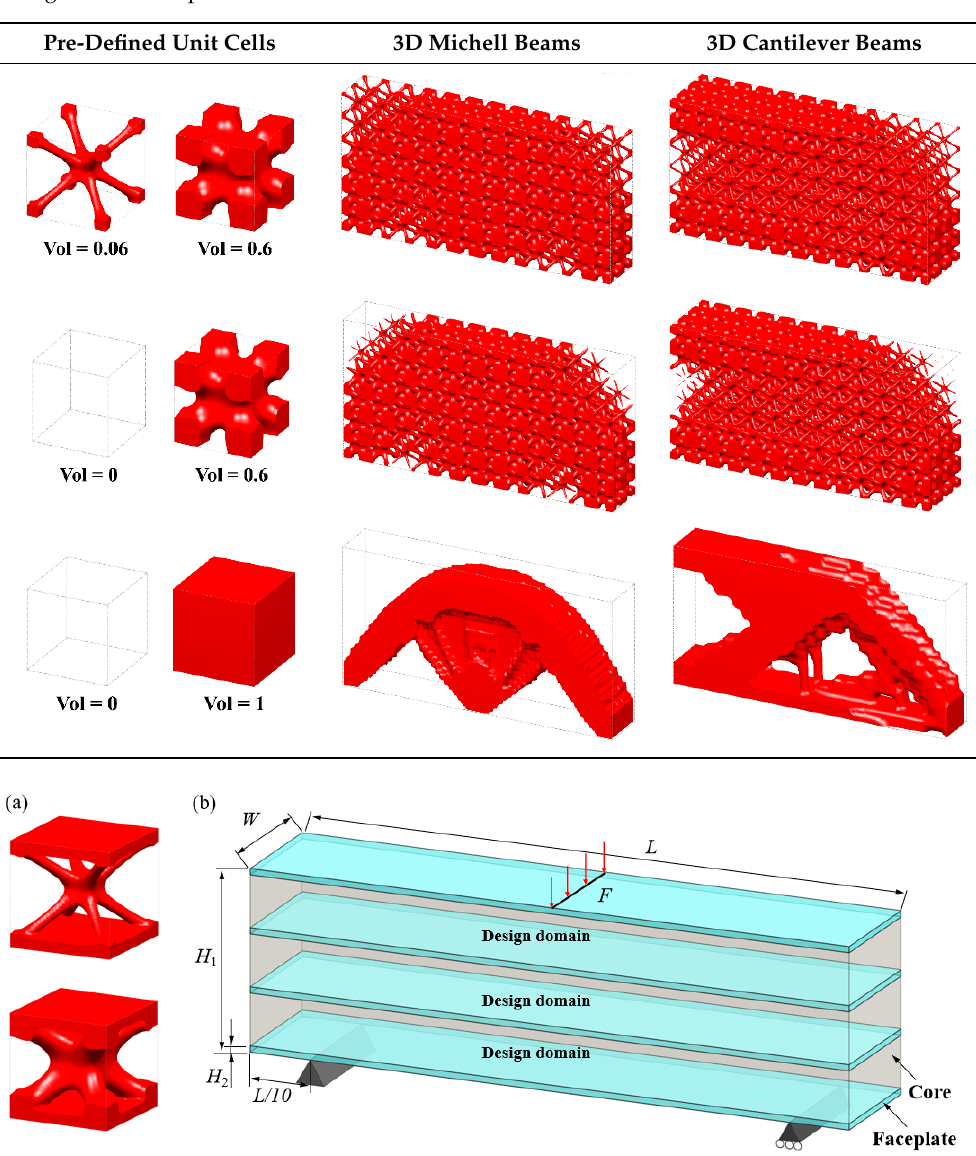
Table 3. The influence of pre-defined unit cells with different volume fractions and topological configurations on optimized results.